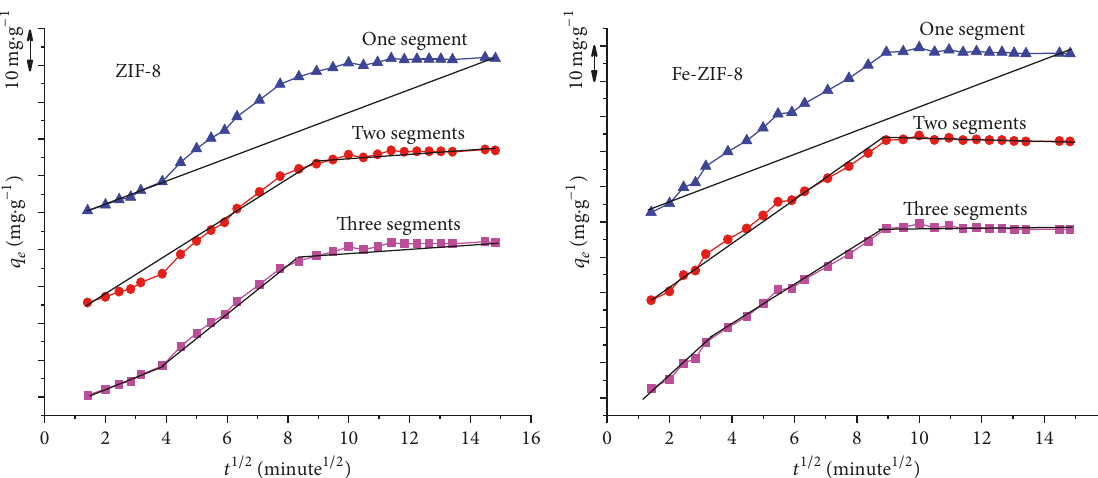
Figure 8: Plot of piecewise linear regression for one, two, and three segments’ based Webber’s model ( 𝐶 = 500 mL; temperature = 30 ∘ C; stirring rate = 500 rpm).